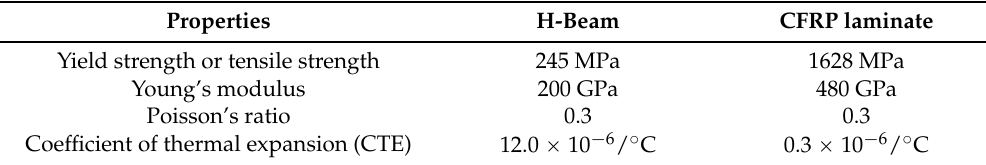
Table 1. Nominal material properties for steel beam and CFRP.